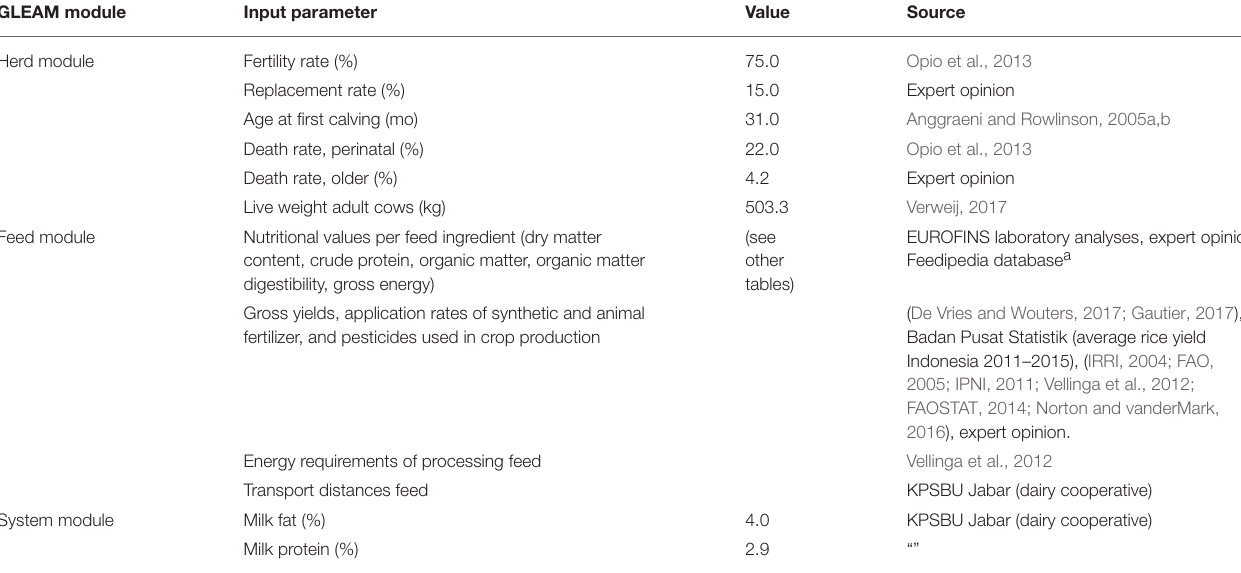
TABLE 2A | Fixed values used as input data in LCA analysis. GLEAM module